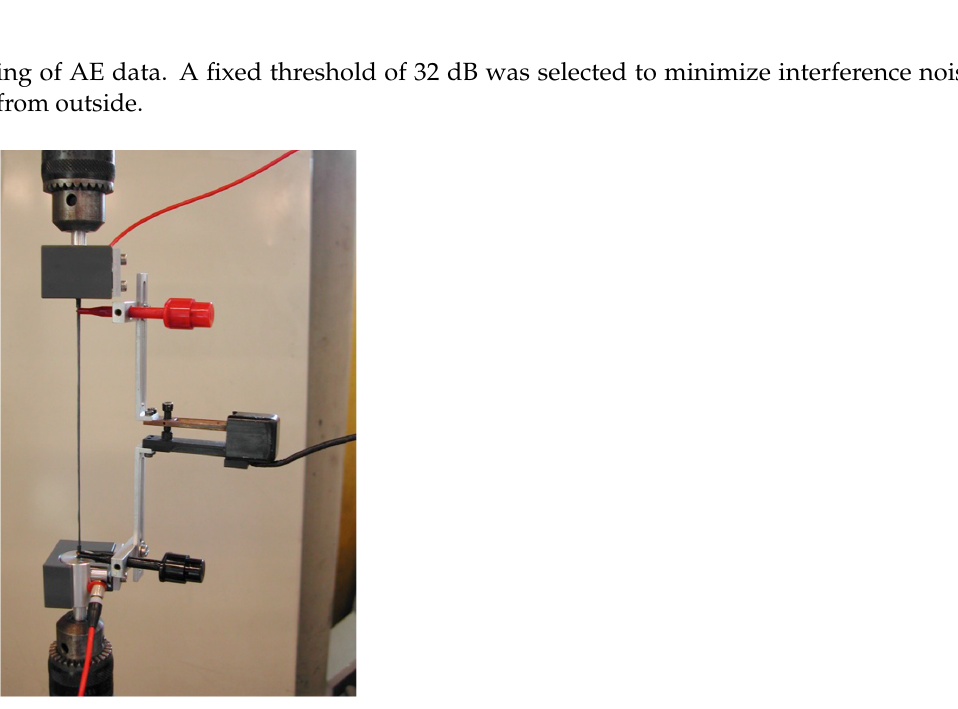
L i n ea r l o ca t i on ( mm ) Figure 2. Force–strain curves obtained on tows with different gauge lengths and 1000 filaments: ( a ) 115 mm gauge length (the typical behavior of a tow with 500 filaments is also shown); ( b ) 40, 80 and 115 mm (also shown are the theoretical curves calculated using Equation (8) for the normal distribution of flaw strengths); ( c ) 115 mm and location of AE events along specimen axis (the parallel red lines delineate gauge length).